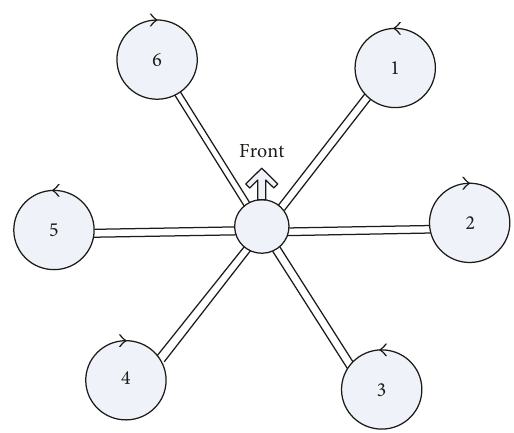
Figure 2: Aerodynamic layout diagram.